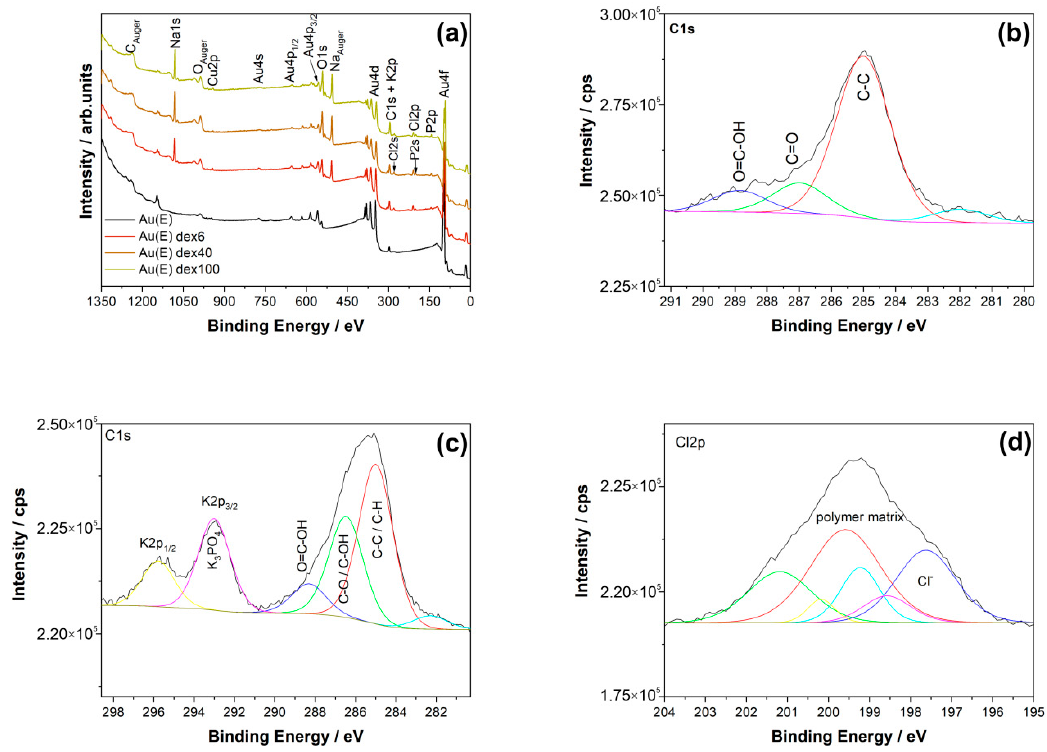
Figure 5. ( a ) XPS spectra for Au(E) samples, unmodified, and modified with cationic dextran derivatives. High-resolution deconvoluted XPS spectra of C 1s for ( b ) unmodified and ( c ) modified Au(E)dex40 sample, and ( d ) Cl 2p spectra for the coated sample.